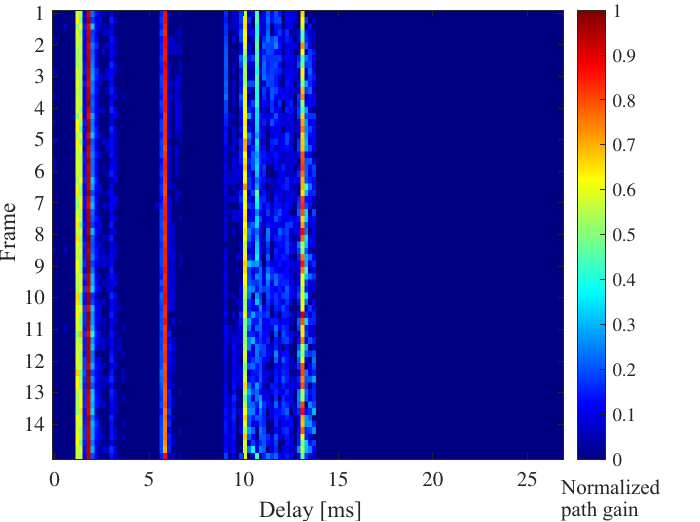
Figure 1. Time-varying multipath channel with clustered-sparse structure estimated in a lake com- munication